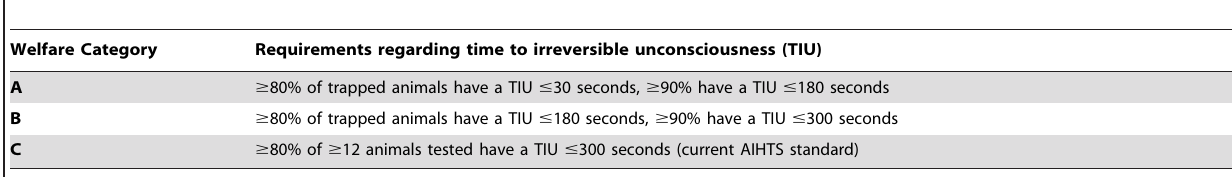
Table 7. Welfare Categories proposed in FERA’s recent review of trapping standards (Talling and Inglis